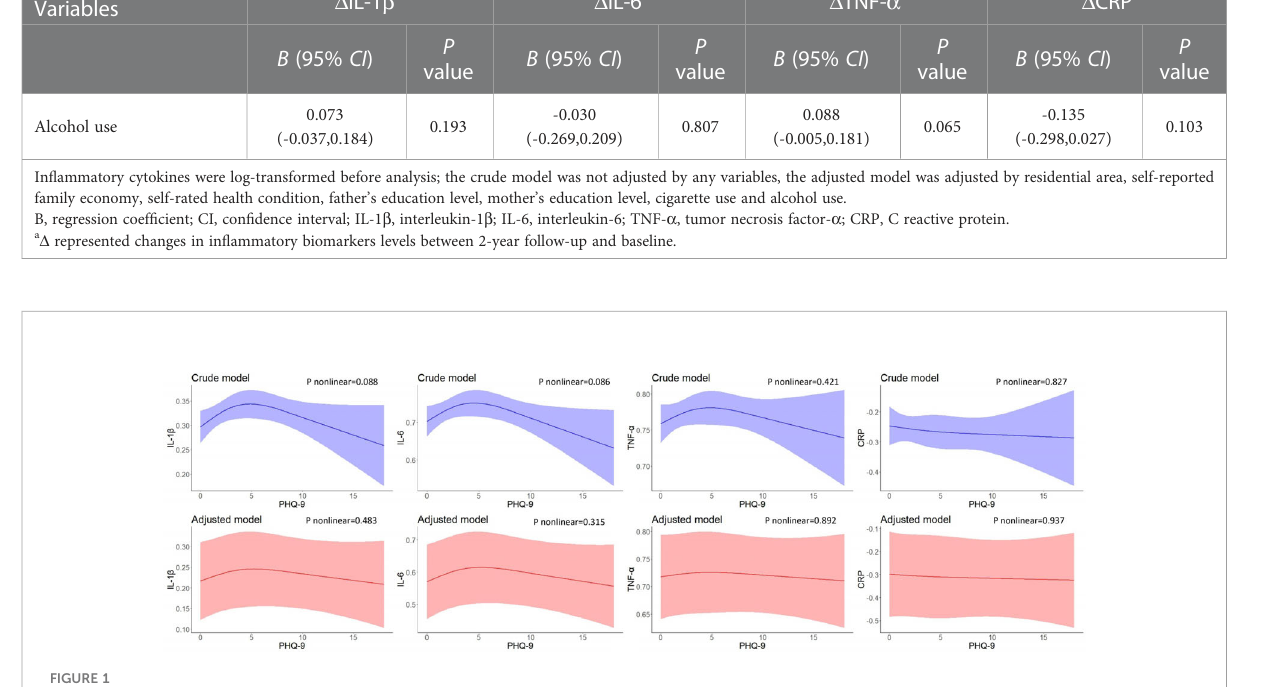
FIGURE 1 Restricted cubic spline models of the associations between PHQ-9 total scores and in fl ammatory biomarkers at baseline (n=723). IL-1 b , interleukin-1 b ; IL-6, interleukin-6; TNF- a , tumor necrosis factor- a ; CRP, C reactive protein. a The blue plot represented the crude model which was not adjusted by any variables, and the red plot represented the adjusted model which was adjusted by residential area, self-reported family economy, self-rated health condition, father ’ s education level, mother ’ s education level, cigarette use and alcohol